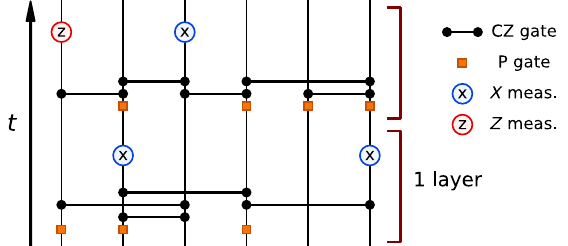
FIG. 1. Schematic of the l -bit circuit with projective measure- ments. This circuit has n ¼ 3 : CZ gates are allowed between qubits i , j with j i − j j < 3 , i.e., nearest and next-nearest neigh- bors. All allowed gates happen with probability 1 = 2 in each